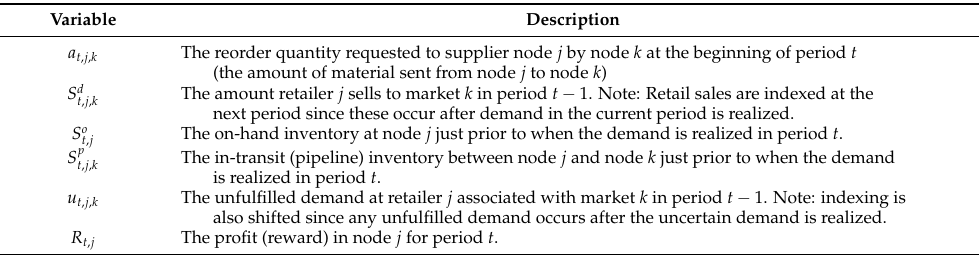
Table 1. Main variables in the inventory management problem (IMP)